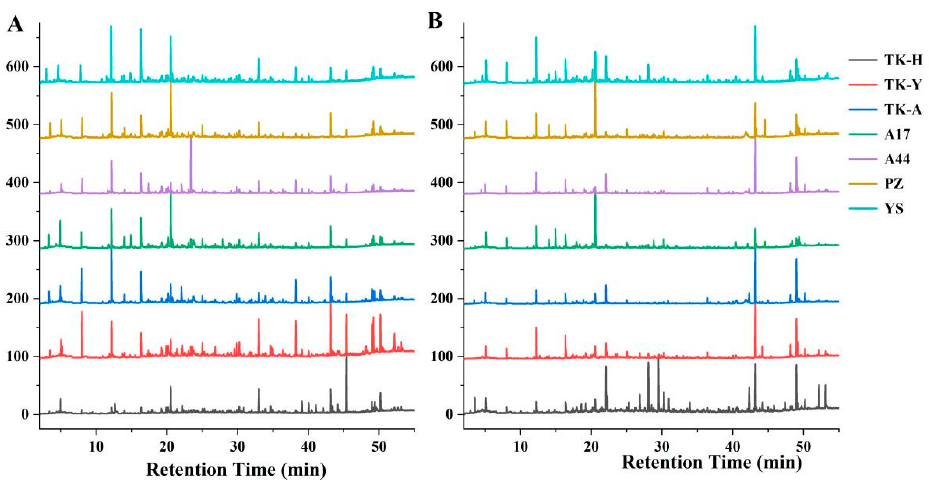
Figure 1. Typical TICs of Taraxacum leaves ( A ) and roots ( B ) determined by HS-SPME/GC–MS.